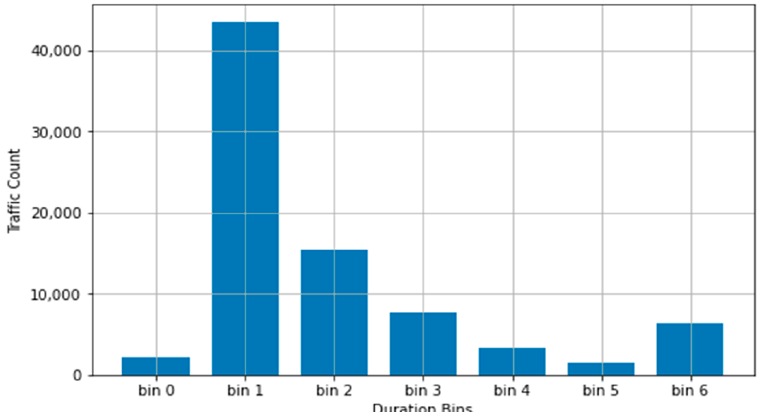
Figure 4. Value distribution for duration across bins after moving-mean logic.